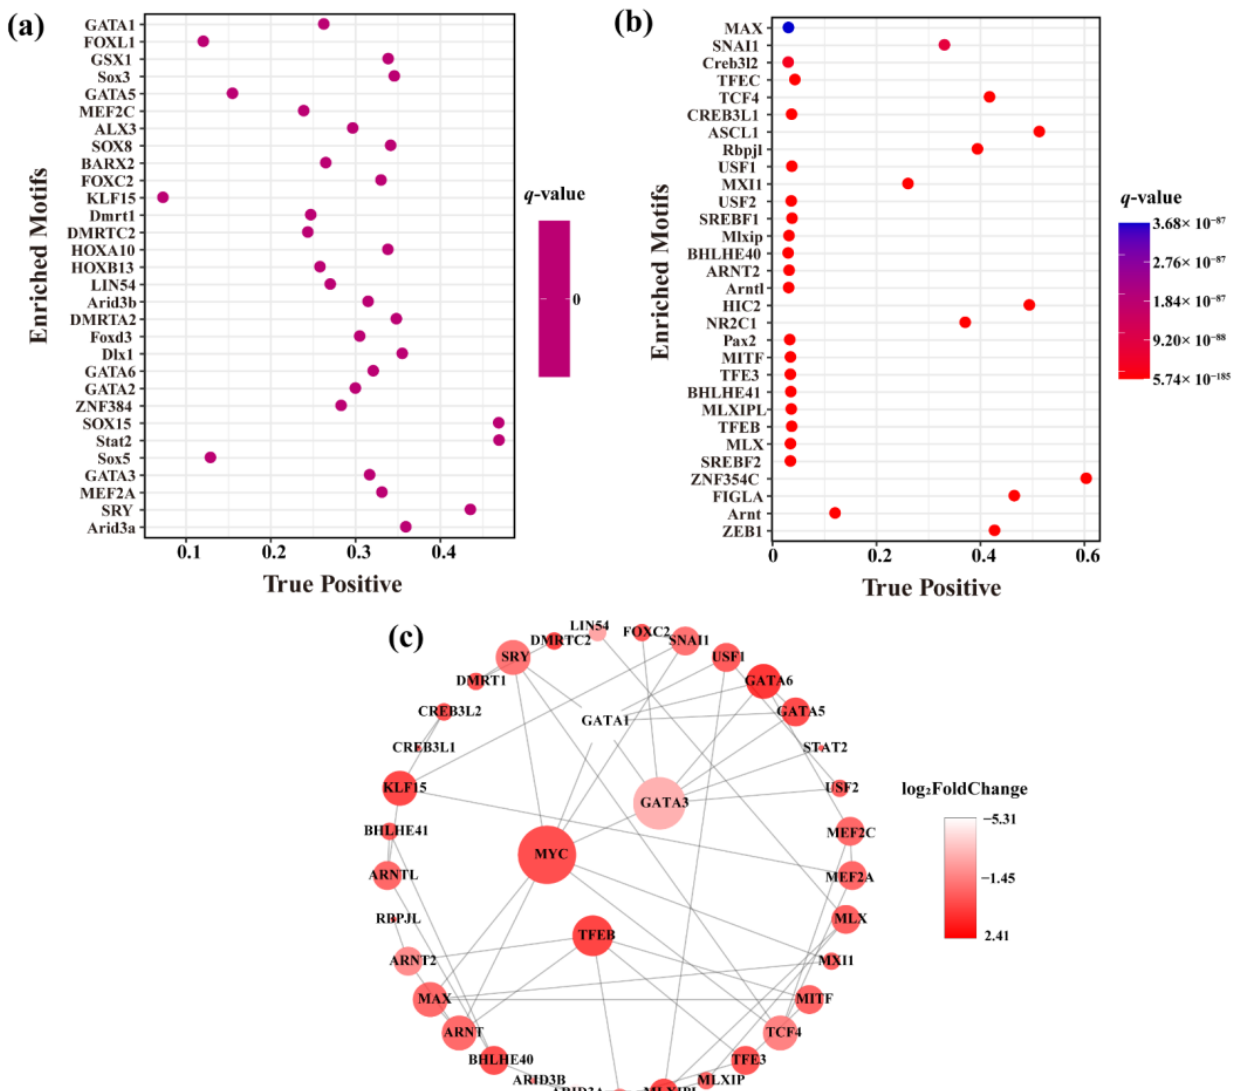
Figure 4. Motif analysis of the differential OCRs. The openness of cattle-yak OCRs can increase ( a ) and decrease ( b ) Motif enrichment results, and ( c ) The interaction network between the different TFs. The size of a node indicates interaction. The color of nodes indicates the differential expression level of TF (log 2 FoldChange).